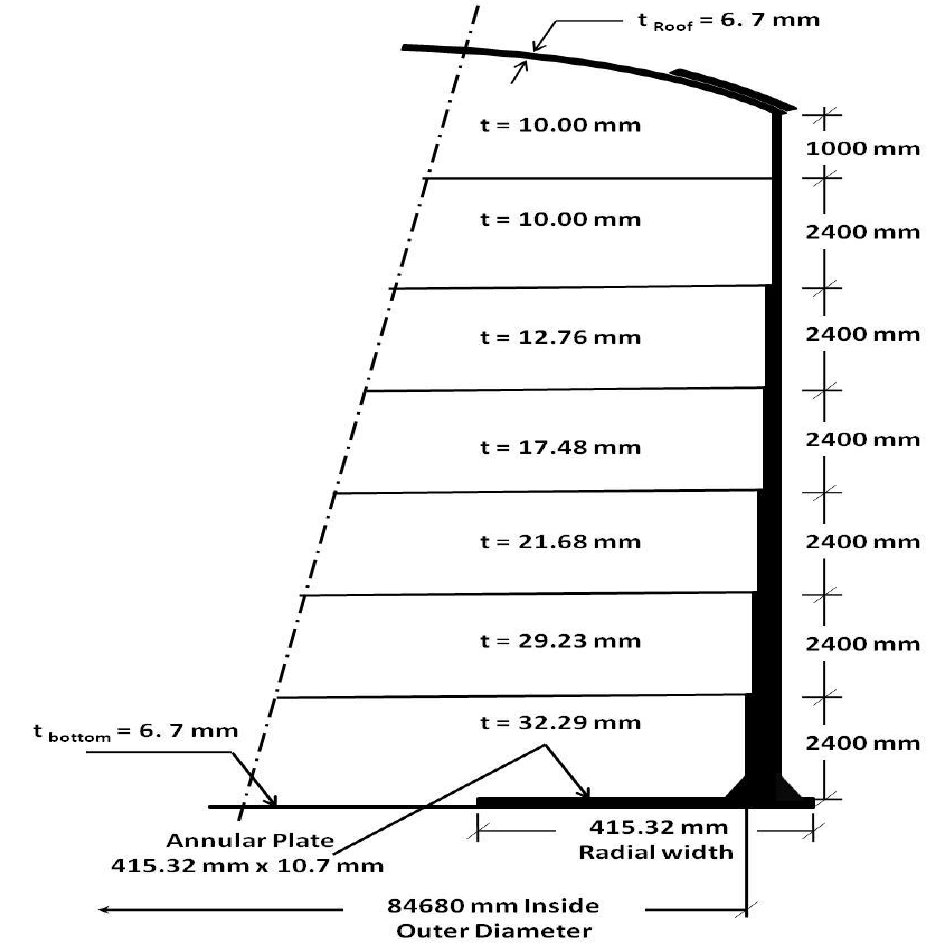
Fig. 11. Shell structure for hot tank.